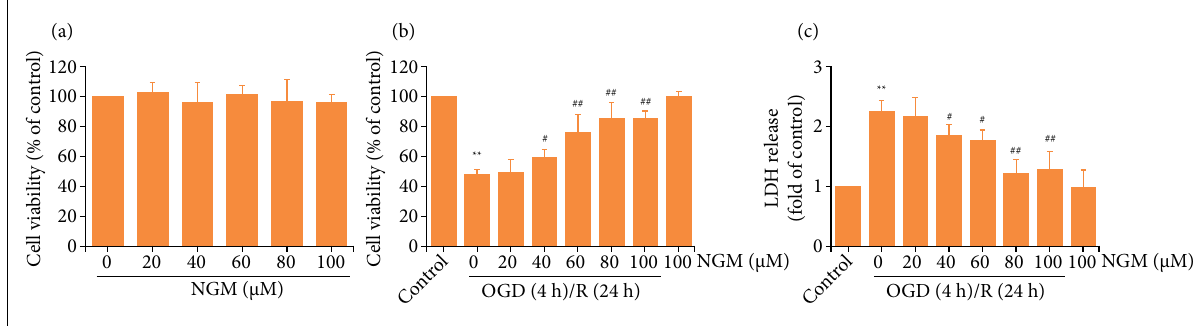
Figure 1 – Effects of naringenin on cell viability and LDH release in OGD/R-exposed HT22 cells. HT22 cells were treated with different concentrations of naringenin (20, 40, 60, 80, or 100 μ mol·L –1 ) for 24 h, and (a) cell viability was detected by CCK-8 assay. HT22 cells were treated with naringenin (20, 40, 60, 80 or 100 μ mol·L –1 ) for 2 h followed by treatment with OGD (6 h)/R (24 h); (b) cell viability was detected by CCK-8 assay; and (c) LDH releases was assayed by LDH cytotoxicity assay kit. Data were expressed as mean ± SD from 3–4 independent experiments. ** P < 0.01 vs. control group; # P< 0.05, ## P < 0.01 vs. OGD/R group. NGN: naringenin; OGD/R: oxygen-glucose deprivation/reperfusion.